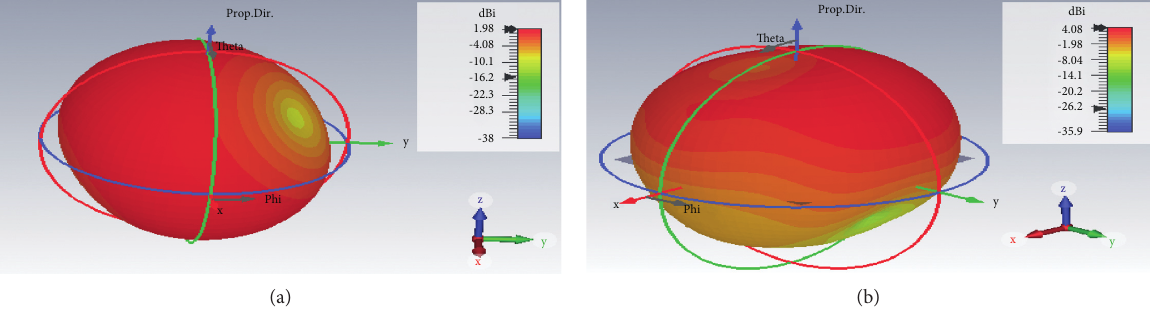
Figure 5: Simulated 3D radiation patterns of the proposed PILA tag antenna when it is placed (a) in the free space and (b) on the 30cm × 30 cm metal